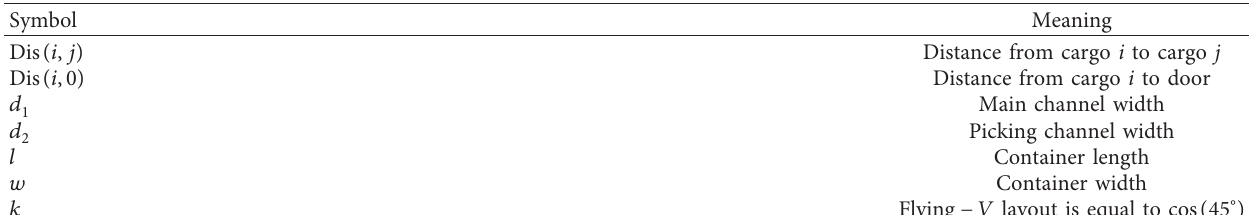
Figure 1: Flying-V layout. Table 1: Symbol